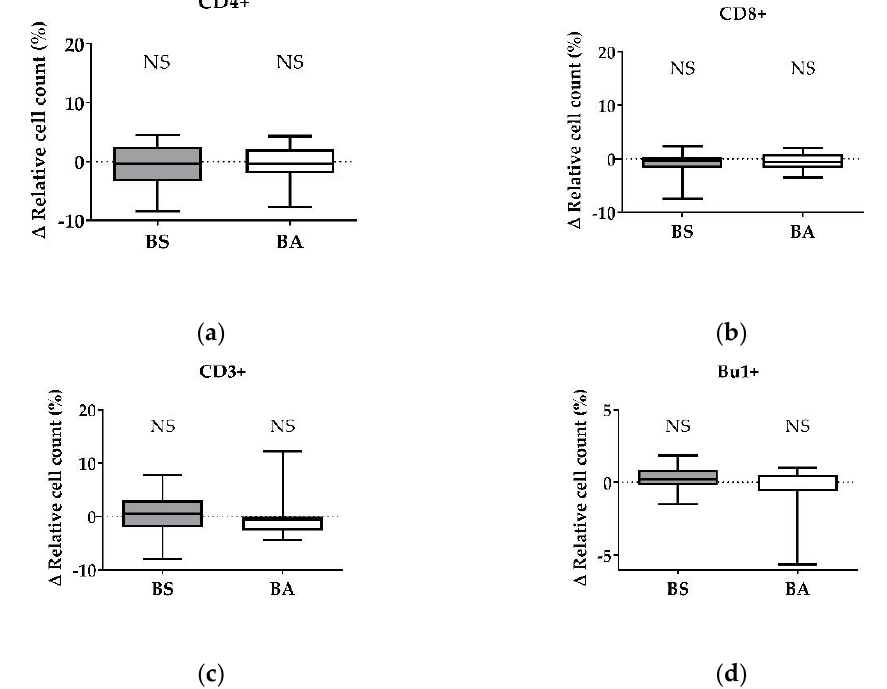
Figure 3. Influence of cell-free culture supernatants of B. subtilis DSM 32315 (grey) and B. amyloliq- uefaciens CECT 5940 (white) on the proliferation of T and B cells. Isolated PBMCs were treated with cell-free supernatants of BS or BA, or left untreated (negative control). After treatment for 24 h, im- mune cells were stained with monoclonal antibodies. The relative cell count was related to heat- treated controls. DAPI was used as a viability marker. ( a ) CD4+ T-helper cells, ( b ) CD8+ cytotoxic T cells, ( c ) all CD3+ T cells, and ( d ) Bu-1+ B cells relative to the vital PBMC cell count. 20,000 vital PBMCs were recorded on a BD FACSCanto II flow cytometer. Data represent 13 (BS) or 12 (BA) biological replicates. Results are presented as box and whisker plots showing the median, with a 25 – 75 percentile range as the box and minimum to maximum as the whiskers. Significance is shown as NS: not significant.